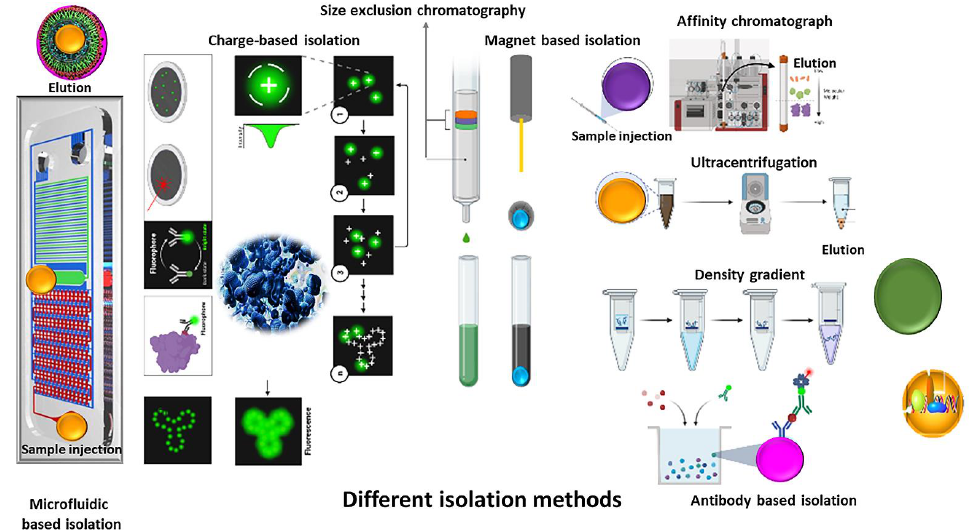
Figure 1. Schematic representation of different methods for extracellular isolation and purification.